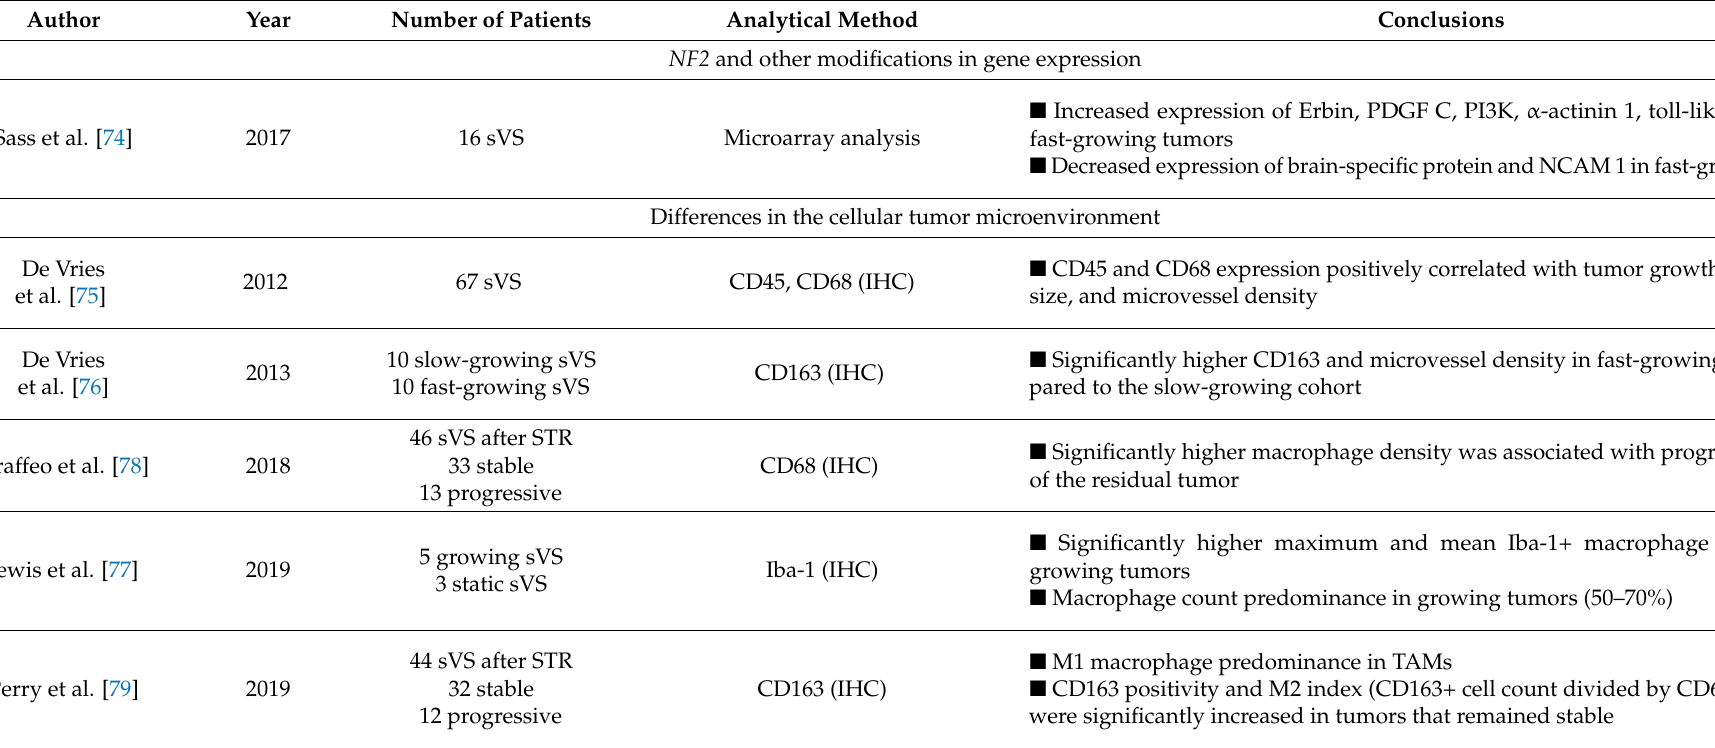
Table 1. Relation of the VS biology and microenvironment to tumor growth—literature overview. (sVS—sporadic VS, STR—stereotactic radiosurgery, PDGF— platelet-derived growth factor, PI3K—phosphatidylinositol 3-kinase, NCAM—neural cell adhesion molecule, IHC—immunohistochemistry staining,